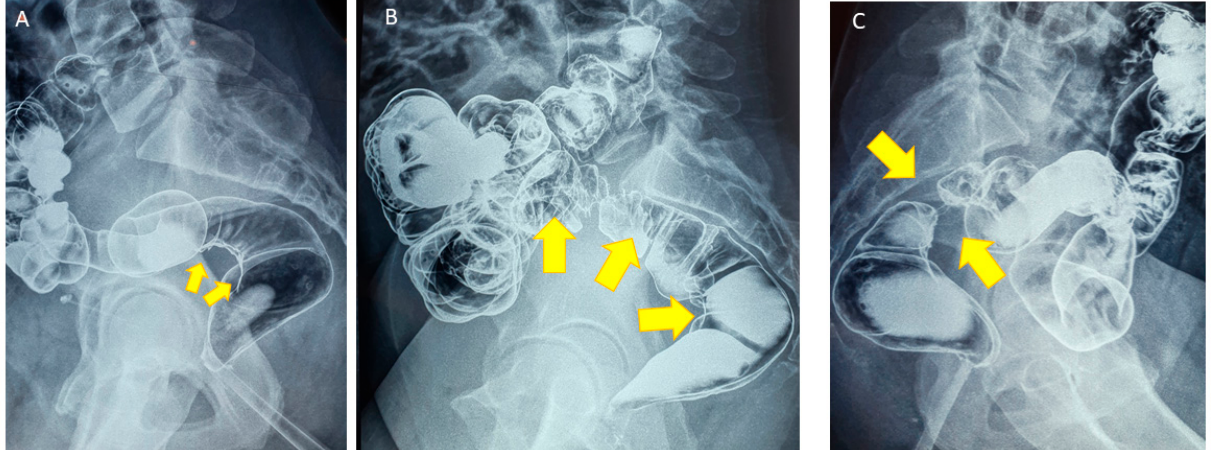
Figure 2. ( A ) Double-contrast profile barium enema showing periviscerity of the rectosigmoid junction because of an infiltration from DE nodule (yellow arrows). ( B ) Double-contrast profile barium enema showing wide and severe rectal muscularis infiltration due to a large nodule (yellow arrows). ( C ) Double-contrast profile barium enema showing circumferential invasion of the muscularis of the rectosigmoid junction (yellow arrows) leading to a major stenosis. As firstly reported by Donnez et al. [38], ureteral involvement is seen in 9.1% of cases